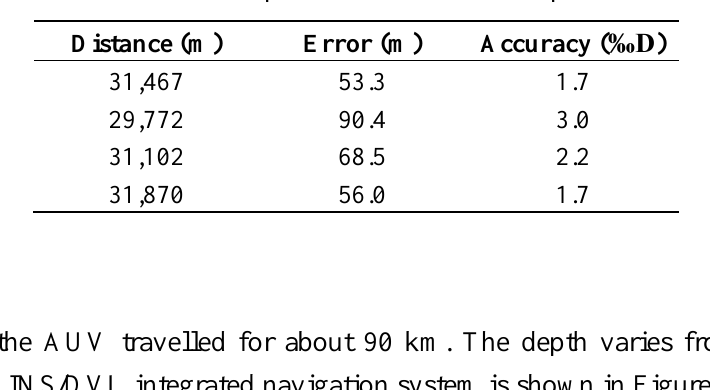
Table 7. On-line experimental results in Experiment 2.